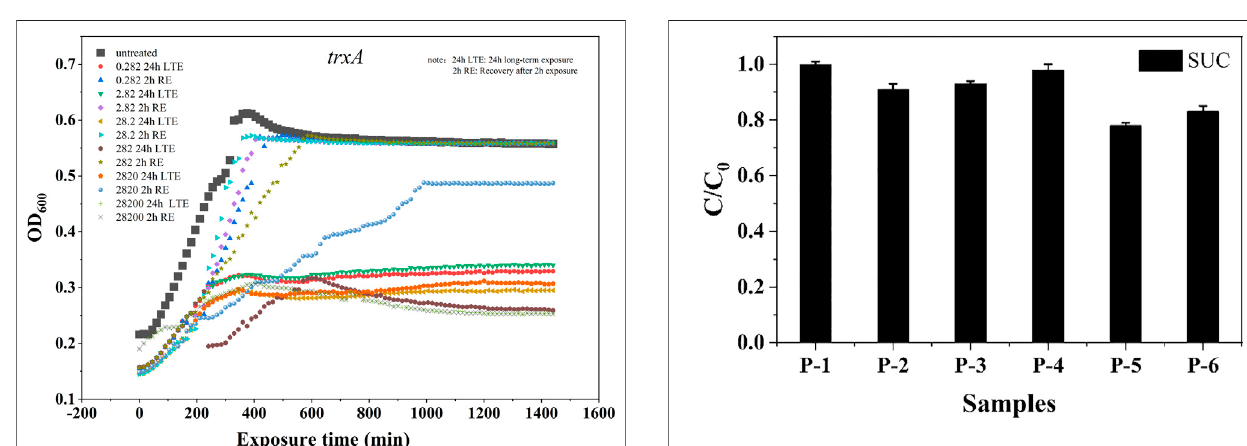
FIGURE 9 | Disinfection process – dependent degradation of SUC. P-1, P-2, P-3, P-4, P-5, and P-6 are SUC (2.82 × 10 4 mg/L), chlorine, chloramine, UV, UV/chlorine, and UV/chloramine, respectively.